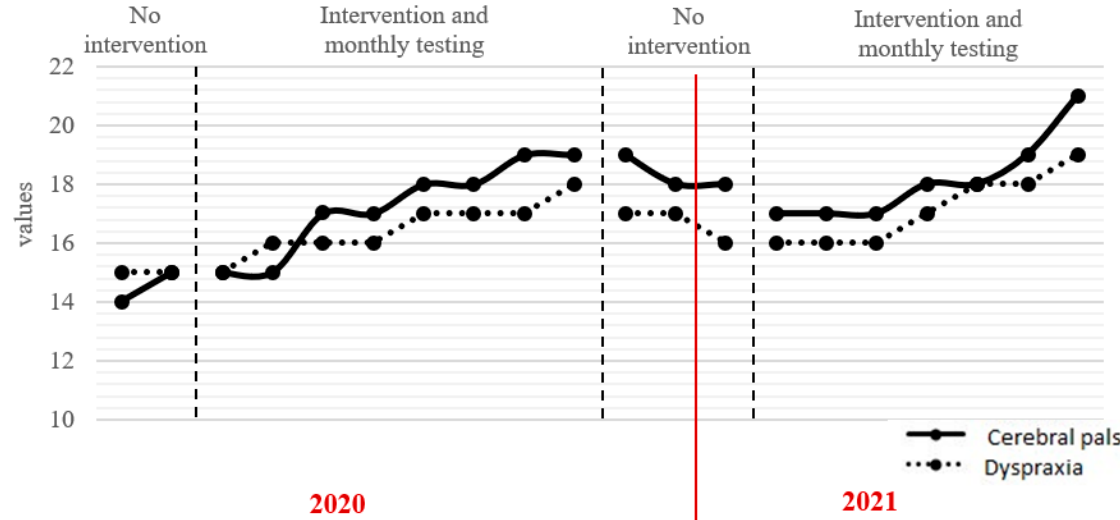
Figure 1. Comparison of the results and the course of development of motor functions in both pa-